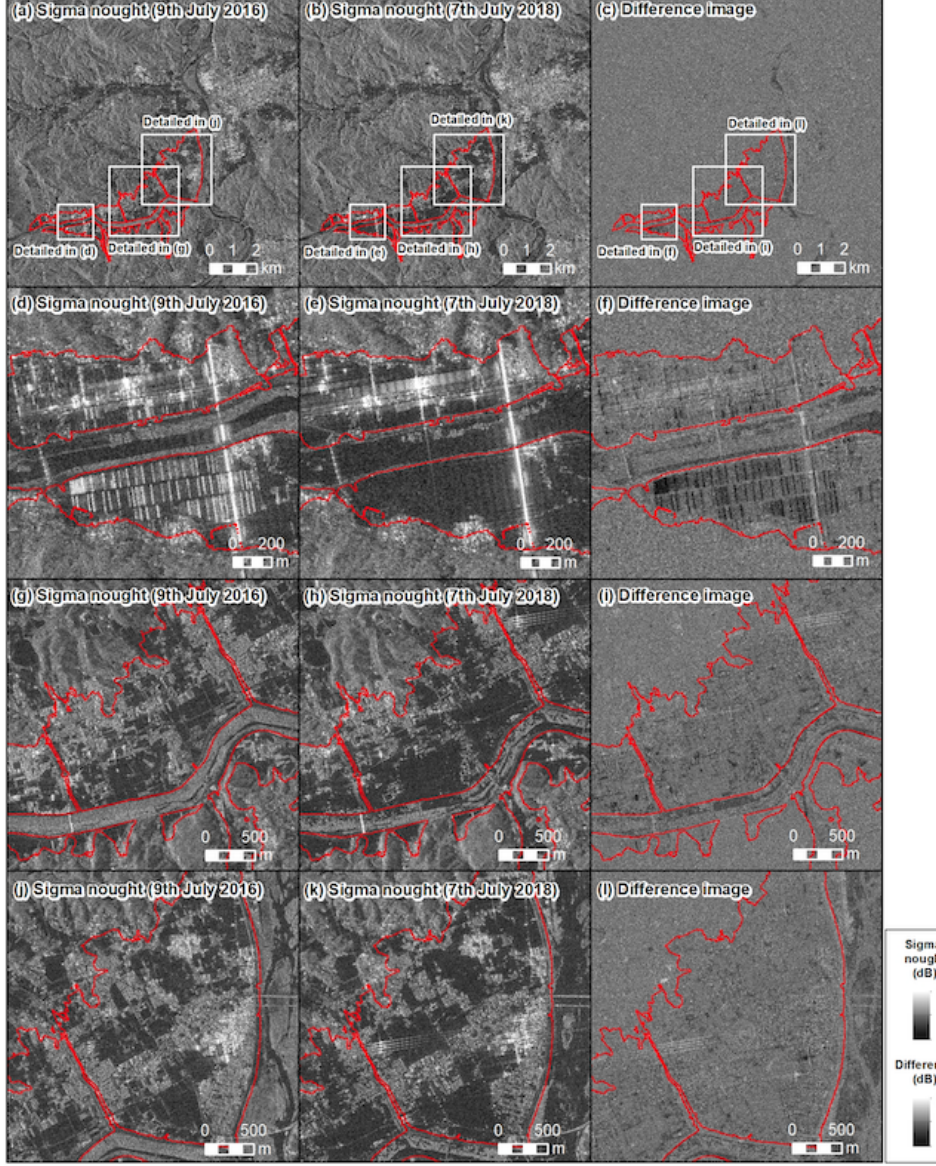
Figure 6. Examples of difference images: ( a ) sigma nought image on 9 July 2016; ( b ) sigma nought image on 7 July 2018; ( c ) difference image of ( a , b ); ( d ) zoomed image of ( a ); ( e ) zoomed image of ( b ); ( f ) difference image of ( d , e ); ( g ) zoomed image of ( a ); ( h ) zoomed image of ( b ); ( i ) difference image of ( g , h ); ( j ) zoomed image of ( a ); ( k ) zoomed image of ( b ); ( l ) zoomed image of ( j , k